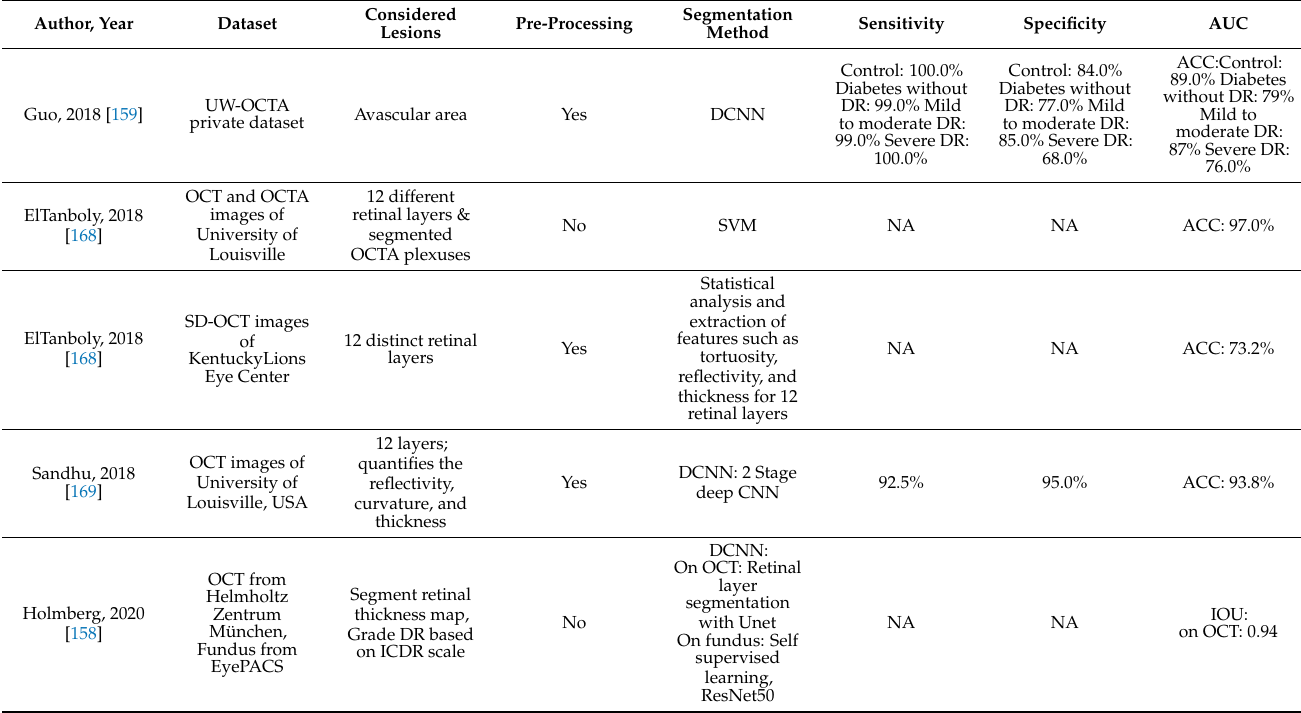
Table 6. Segmentation-based studies in DR detection using OCT, OCTA